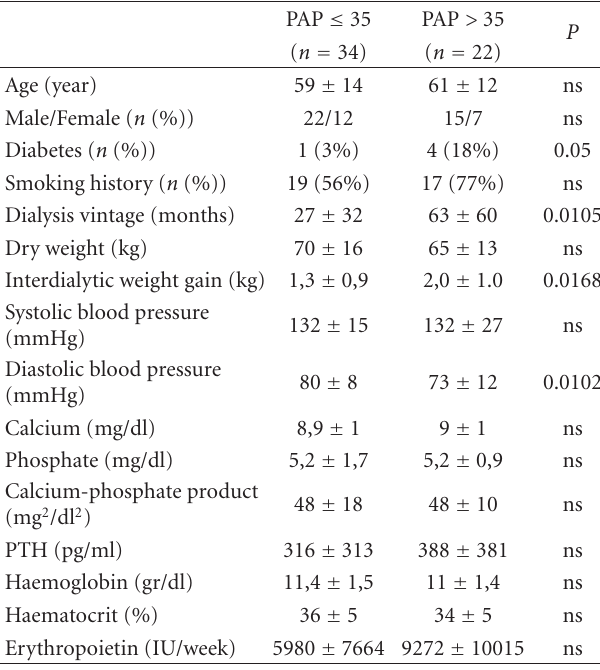
Table 2: Clinical and laboratory data of patients with and without pulmonary hypertension.